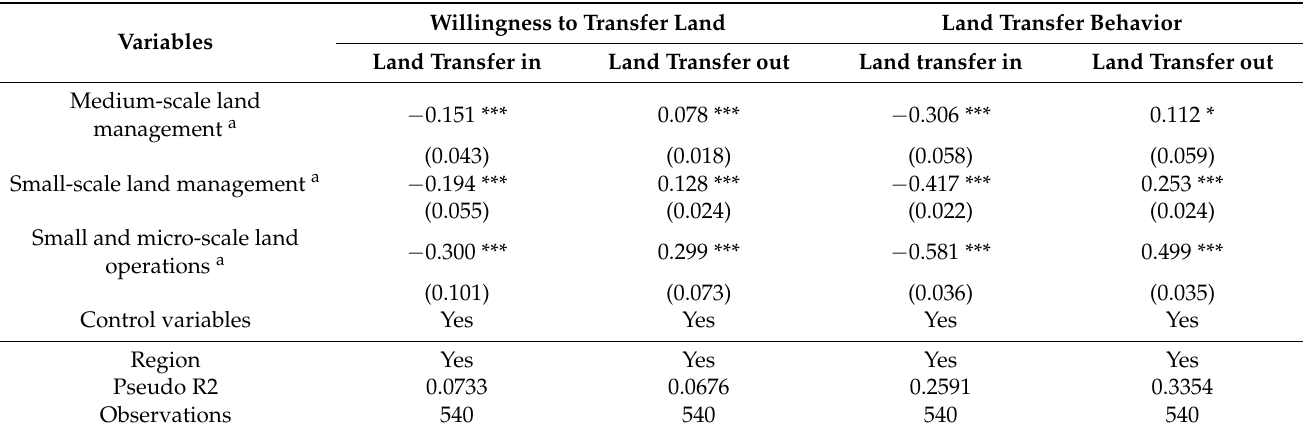
Table 5. Robustness tests for the variable substitution